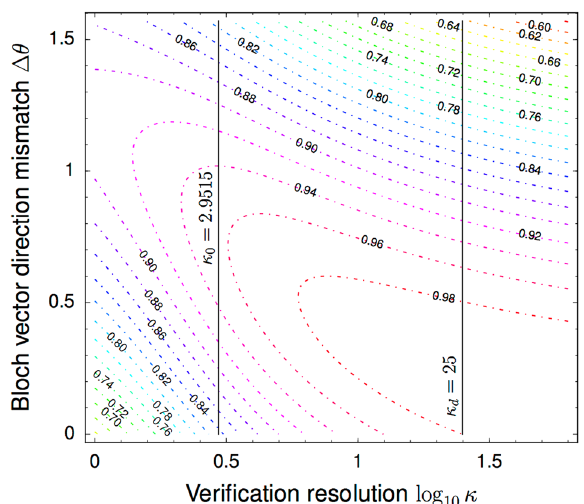
Fig. 2 Contour plot showing how the probability of detecting a qubit of an unknown state | ψ ( θ , ϕ ) 〉 for money veri fi cation depends on the imperfect choice of the measurement direction Δ θ and the photon veri fi cation (or discrimination) resolution κ . Speci fi cally, this probability is equivalent to the fi delity F proc ( Δ θ , κ ) for which the Bloch vector is rotated with respect to its correct orientation by Δ θ for a given value of κ . Note that the probability does not depend on θ or ϕ , but only on Δ θ , which measures the angle between the original and rotated Bloch vectors. The solid black lines mark two speci fi c values of κ : κ 0 = 2.9515 describes the minimal resolution needed to detect an attack with an optimal universal cloning machine and κ d = 25 corresponds to the resolution reached in our experiment. Note that the shape of the depicted relation depends on the dispersion function of the detector. Here, this function